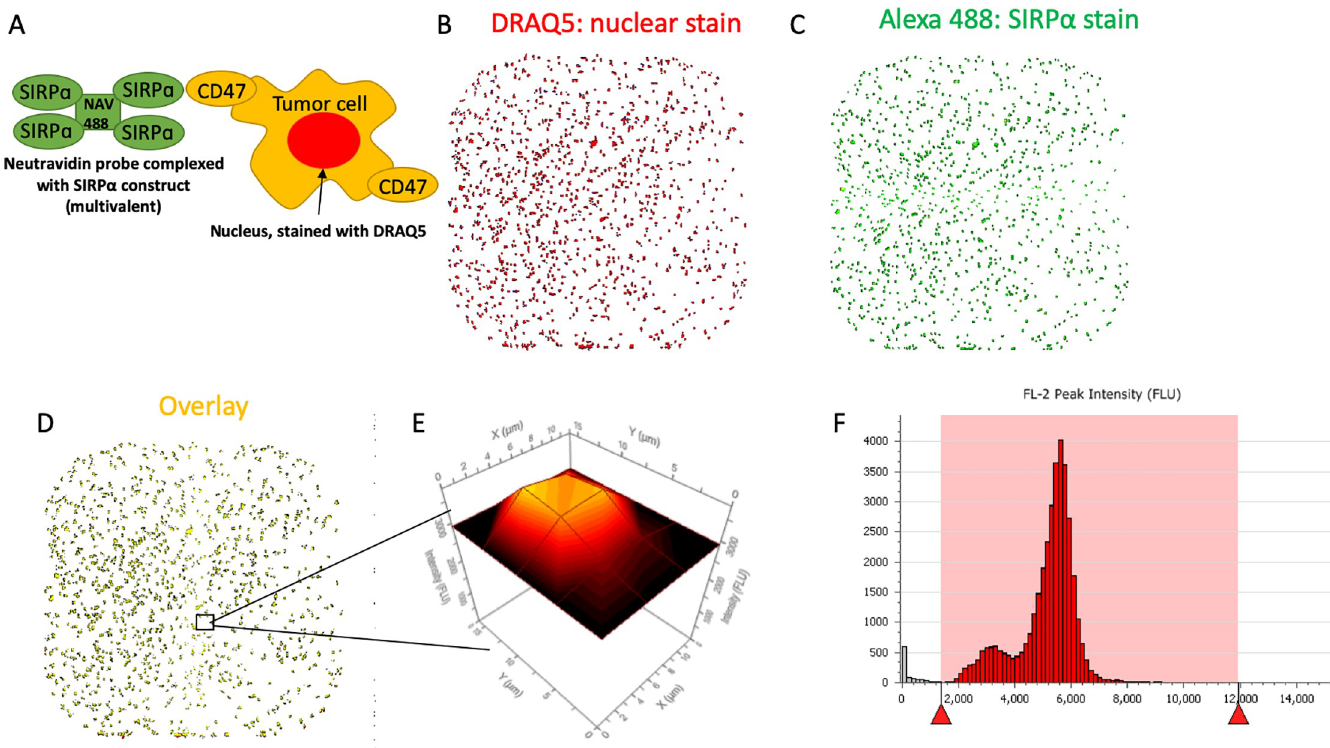
Fig 2. (A) Schematic of the LSC assay showing the multivalent Alexa-488 conjugated neutravidin (NAV-488) SIRP α probe binding to CD47+ tumor cells stained with the nuclear dye, DRAQ5. (B-D) Representative images of all CD47+ Jurkat cells in a single well (B) DRAQ5 nuclear stain for object classification (C) Alexa-488 conjugated SIRP α probe signal, and (D) the overlay of B and C indicating cell-specific staining. (E) The size and signal intensity of each object in the well are captured and (F) represented as in a typical flow cytometry histogram. Red triangles and shaded area indicate the signal limits that define the cell population of interest.